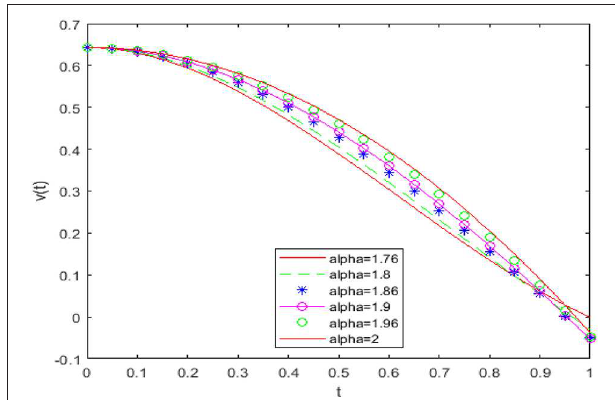
2 and n 3 for Liénard = =